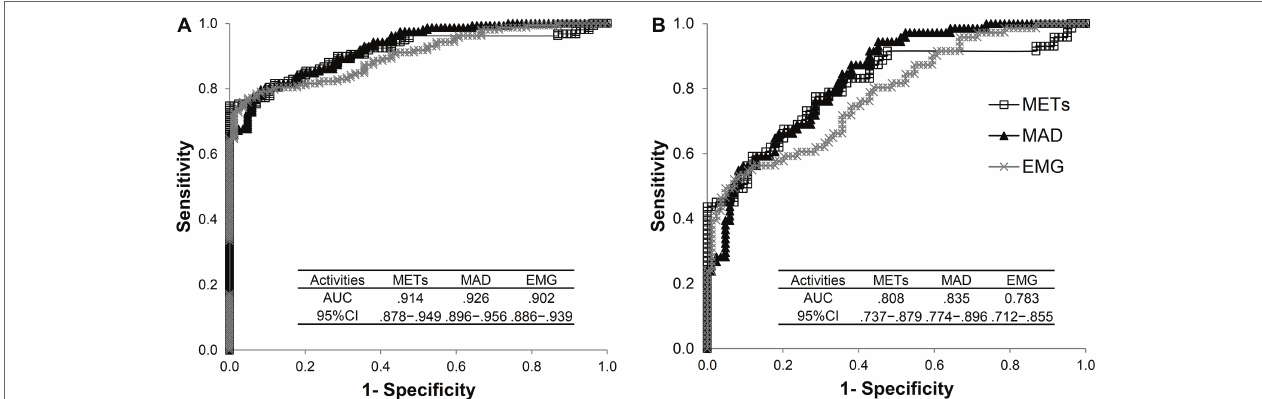
FIGURE 2 | The ability of METs, MAD, and EMG to discriminate sedentary and non-sedentary activities. The area under the curve (AUC) with 95% confidence interval (CI) was determined from the receiver operating characteristic curves. The activities included lying down, sitting quietly, sitting while playing mobile game, standing quietly, standing while playing mobile game, walking on a treadmill at 4 and 6 km/h, and self-paced walking (A) . The activities included lying down, sitting quietly, sitting while playing mobile game, standing quietly, and standing while playing mobile game (B) .